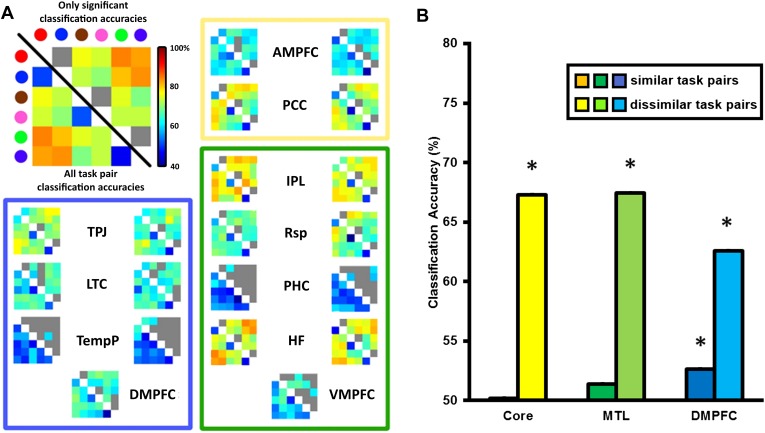
Classification accuracy (CA) within the DMN sub-network ROIs.(A) Classification accuracies between different task pairs in all DMN ROIs. Large correlation matrix used as example is the same as left HF. The colour of the circle in the key matches with the colour borders used to indicate each task in Figure 1A: Red for ‘bigger than a shoebox?’, blue for ‘living?’, brown for ‘same shape?’, pink for ‘same height?’, green for ‘does adding A make a word?’, purple for ‘does adding I make a word’? Matrices show the classification accuracy of decoding each task pair; values below the diagonal show classification accuracy for all task pairs, while non-grey values above the diagonal show only decoding that survived the threshold for statistical significance. The colour borders indicate the sub-network that the ROIs belong to: core (yellow), MTL (green), and DMPFC (blue). ROIs on the left side of each box are from the left hemisphere, those on the right are from the right hemisphere. (B) All three sub-networks demonstrated above-chance classification accuracy when decoding dissimilar tasks, while only the DMPFC sub-network demonstrated significant decoding of similar task pairs. Error bars indicate standard error. * indicates p < 0.05.